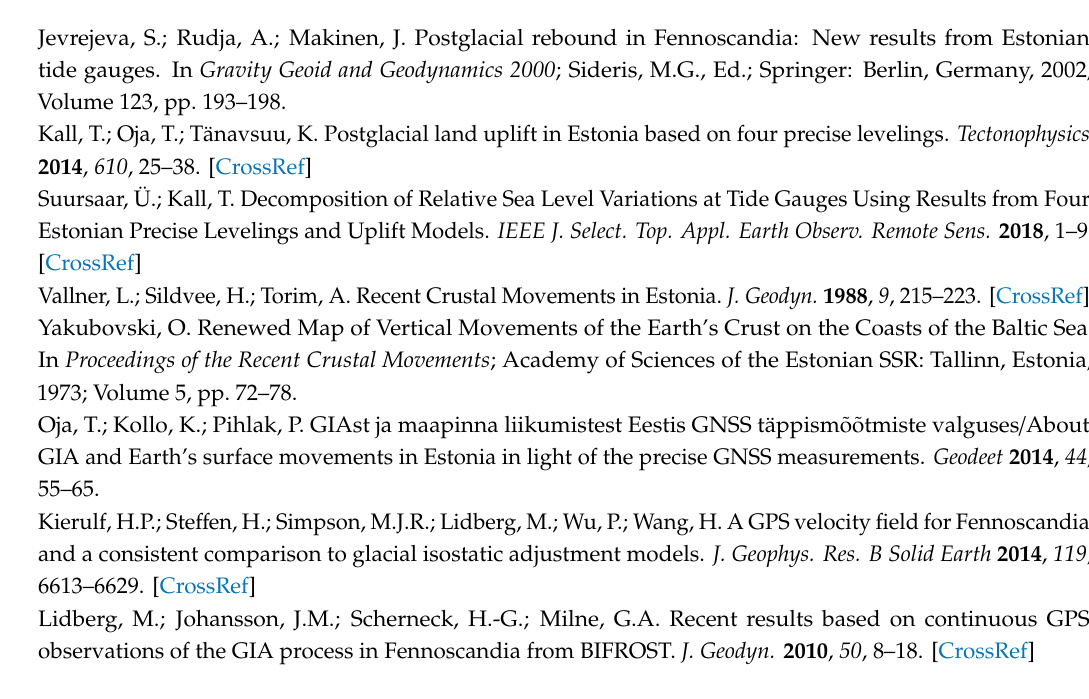
Table S1: Power spectral density plots of time-series residuals of GOA_2 and BERN_2 solutions, Table S2: Spectral indexes of BERN_2 and GOA_2 solutions from PLN + WN and GGM noise models, Table S3: Characteristics of seasonal signals of GOA_2 solution, Table S4: Characteristics of seasonal signals of BERN_2 solution, Table S5: Time-series plots of GOA_2 and BERN_2 solutions, Table S6: Velocities and velocity uncertainties from Tsview, BERN_2, GOA_2, and MIDAS solutions, Table S7: Absolute Up velocities from LU model NKG2005LU [41], Table S8: Absolute Up velocities from LU model NKG2016LU [10], Table S9: Up velocities from GIA model D1 [42], Table S10: North, East, and Up velocities from GIA model NKG2016GIA [10], Table S11: North, East, and Up velocities from GIA model ICE-6G(VM5a) [43], Table S12: North, East, and Up velocities of Estonian cGNSS stations from BIFROST2016 solution in ITRF2008 reference frame